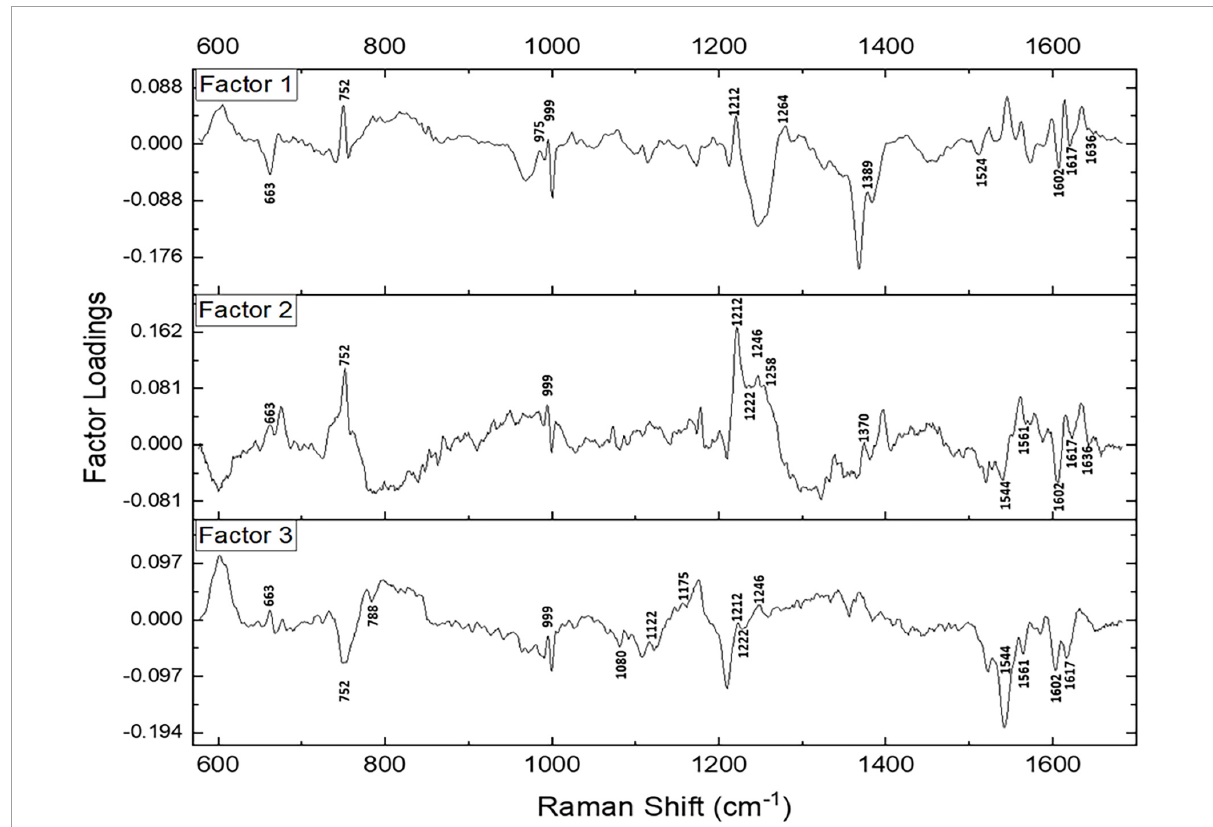
FIGURE3 Spectral loadings of the PC factors (Factor 1, Factor 2, and Factor 3) between RBCs of healthy and disease